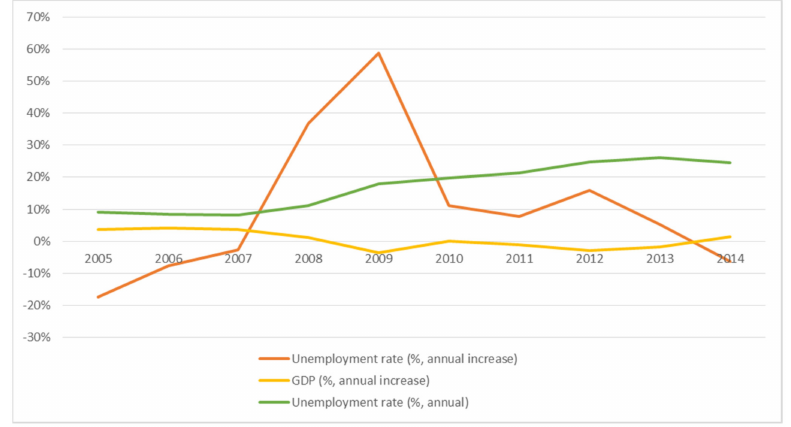
Figure 1. Macroeconomic variables’ evolution in Spain (2005–2014). Source: World Bank Open Data (2021).